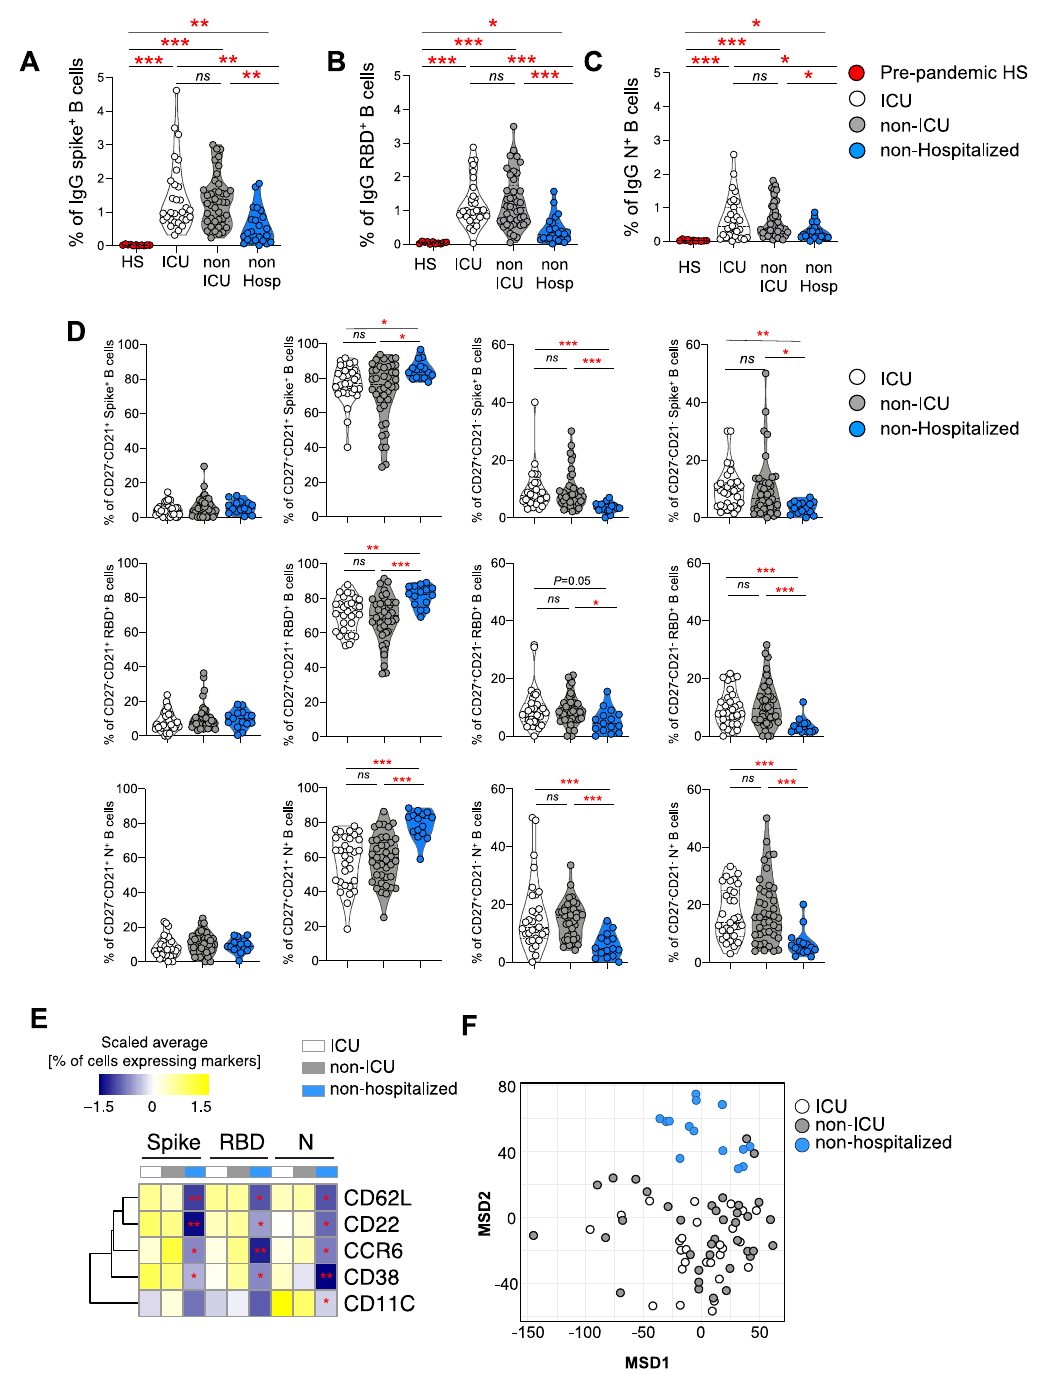
Figure 3. Distribution of SARS ‐ CoV ‐ 2 ‐ specific B cells in ICU, non ‐ ICU, and non ‐ hospitalized individuals. PBMCs from individuals with detectable SARS ‐ COV ‐ 2+ B cells from ICU (N = 31), non ‐ ICU (N = 41), and non ‐ hospitalized (N = 15) individuals at 6 months POS were profiled via mass cytometry, based on the IgG immunoglobulin isotype expression and/or by the combination of CD27 and CD21 markers identifying intermediate memory (IM; CD27 − CD21+), classical resting memory (RM; CD27+ CD21+), activated memory (AM; CD27+CD21 − ), and tissue ‐ like memory (TLM; CD27 ‐ CD21 − ). Frequencies of IgG+ ( A ) Spike, ( B ) RBD, and ( C ) N ‐ specific B cells from ICU (N = 31), non ‐ ICU (N = 41), and non ‐ hospitalized (N = 23) individuals at 6 months POS and from pre ‐ pandemic controls (N = 11). ( D ) Frequencies of Spike+, RBD+ and N+ B cells within the CD27 − CD21+(IM), CD27+CD21+(RM), CD27+CD21 − (AM), and CD27 − CD21 ‐ (TLM) B cells. ( E ) Heat map showing scaled mean marker expression in Spike+, RBD+, and N+ B cells from ICU, non ‐ ICU,